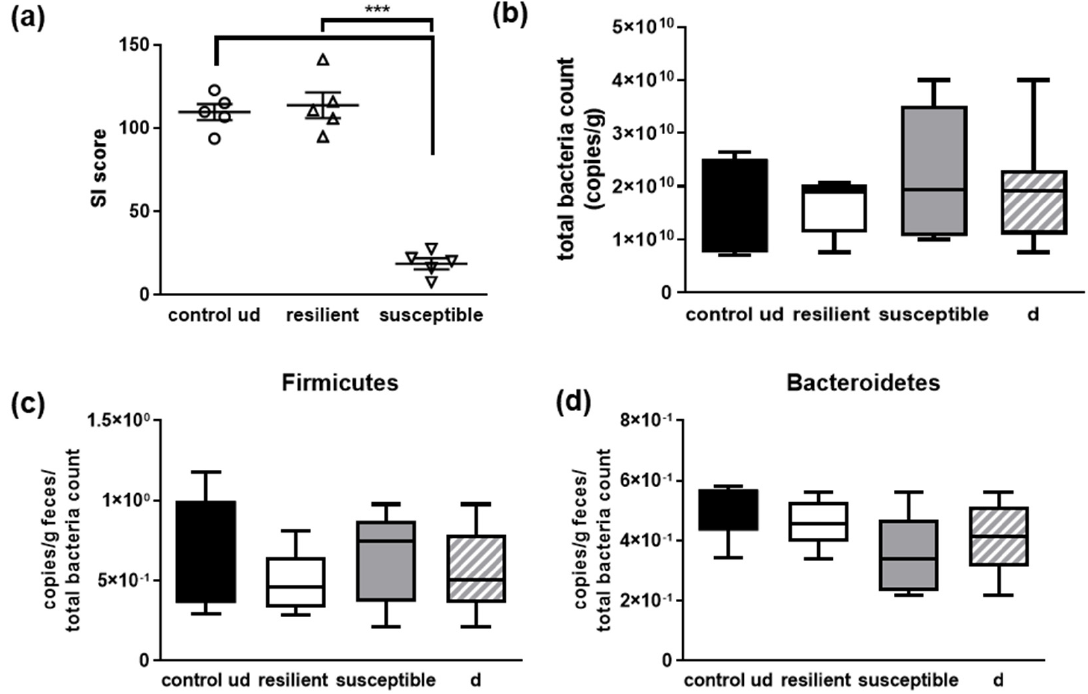
Figure 5. General parameters of the microbiome of defeated and undefeated mice. ( a ) Mice were selected from the group of control mice (Figure 2) due to their achieved SI score, with resilient mice having a comparably high score and susceptible mice characterized by a low score. ( b ) The bacterial count per g of feces was measured as well as the relative amount of Firmicutes ( c ) and Bacteroidetes ( d ) via qPCR. Data are shown as means and min to max. Statistics were performed using one-way ANOVA with Fisher’s LSD test (*** p < 0.001). None of the comparisons was statistically significant (n = 5 per group; undefeated controls = ud; defeated controls = d (mean of resilient and susceptible, n = 10)).